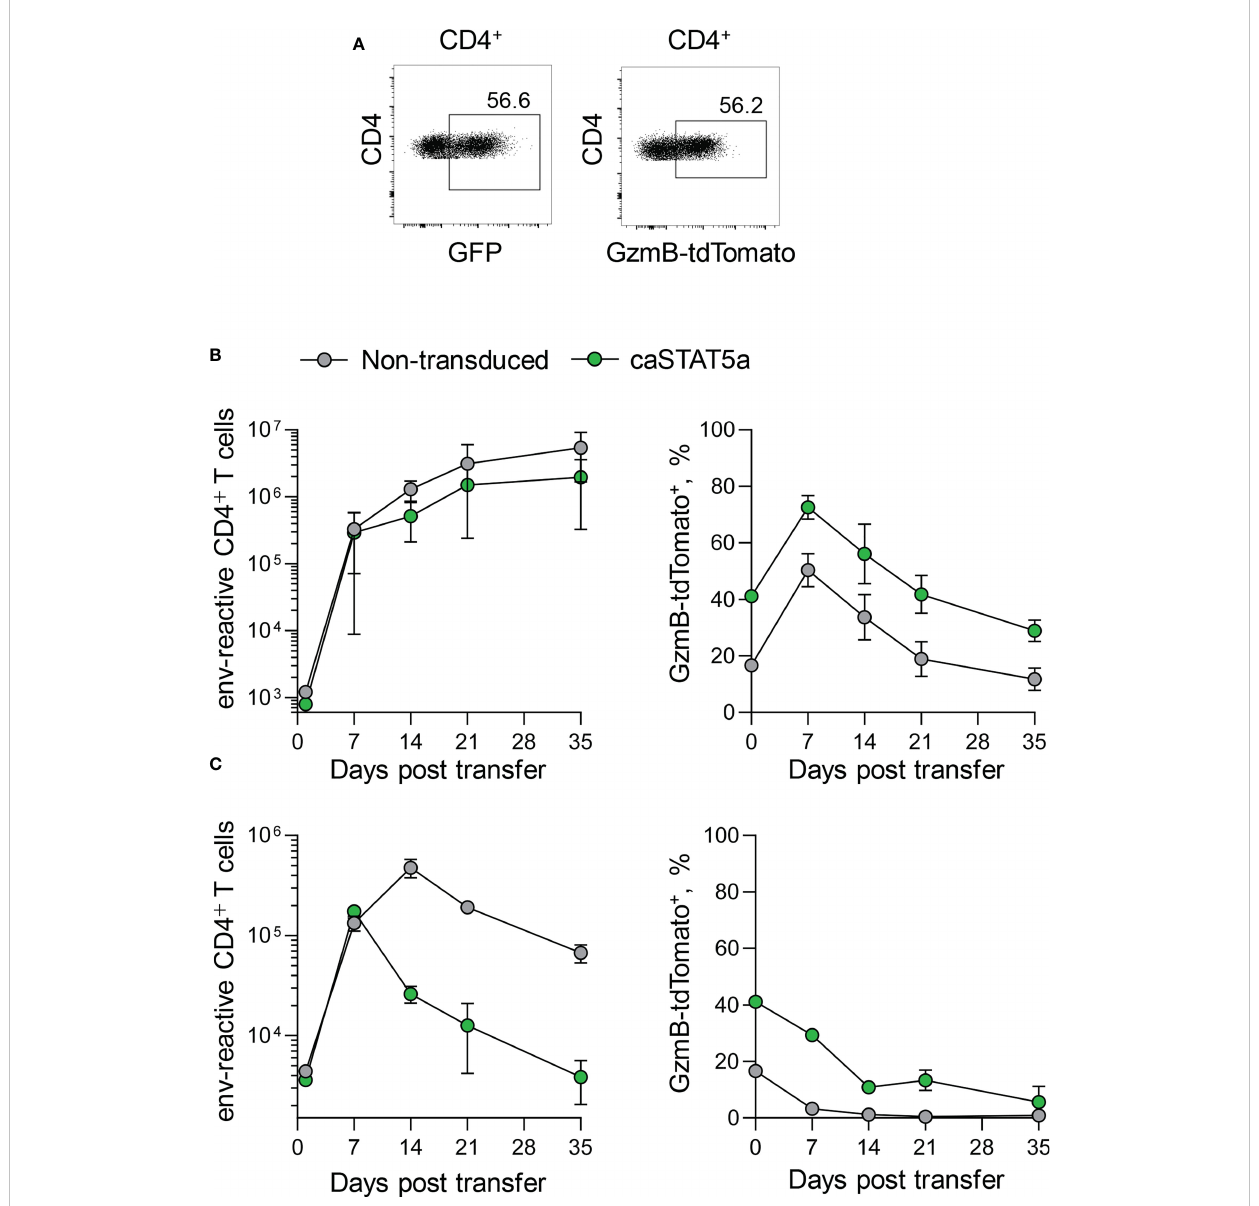
FIGURE 3 STAT5-dependence of GzmB expression in CD4 + T cells. (A) Flow-cytometric detection of GFP + caSTAT5a-transduced (top) and GzmB-tdTomato + (bottom) env-reactive donor CD4 + T cells in spleens of Rag1 -/- recipient mice. (B) Absolute numbers (left) and GzmB-tdTomato expression (right) of non-transduced and caSTAT5a-transduced env-reactive donor CD4 + T cells in the spleens of Rag1 -/- recipient mice at indicated time points after adoptive transfer. (C) Absolute numbers (left) and GzmB-tdTomato expression (right) of non-transduced and caSTAT5a-transduced env-reactive donor CD4 + T cells in the spleens of WT recipient mice at indicated time points after adoptive